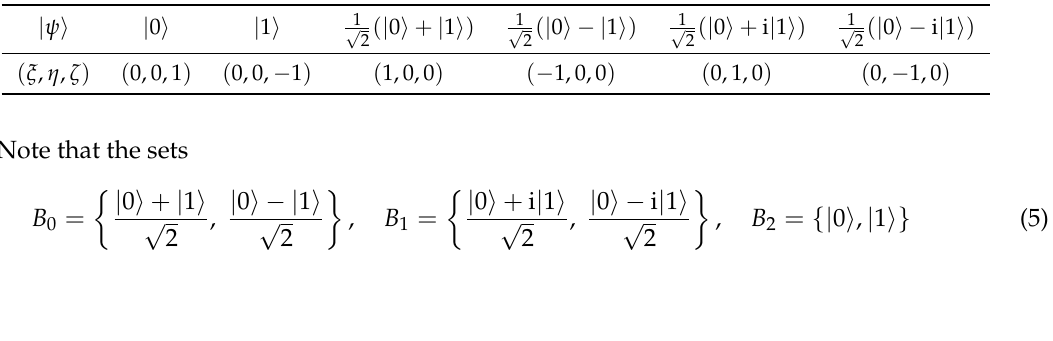
| 0 (cid:105) + e i ϕ sin θ | 1 (cid:105) and points ( ξ = sin θ cos ϕ 2 2